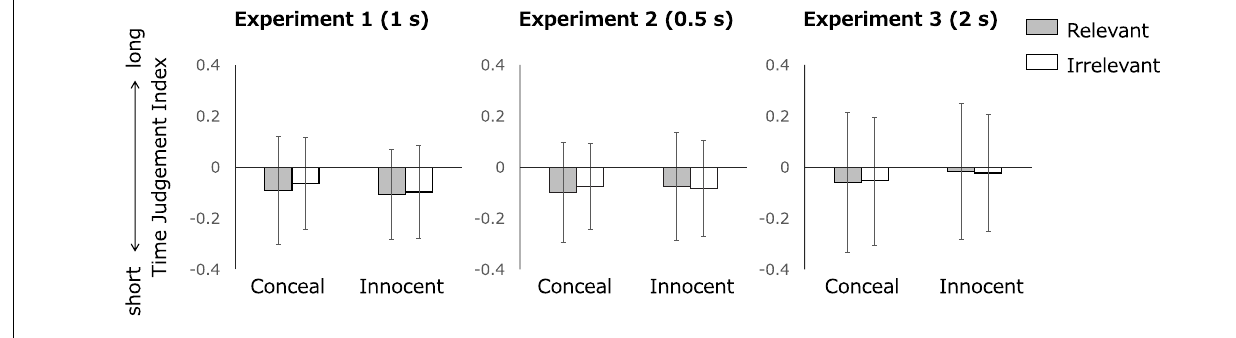
FIGURE 2 | The mean time judgment index for each condition and each item. Error bars denote standard